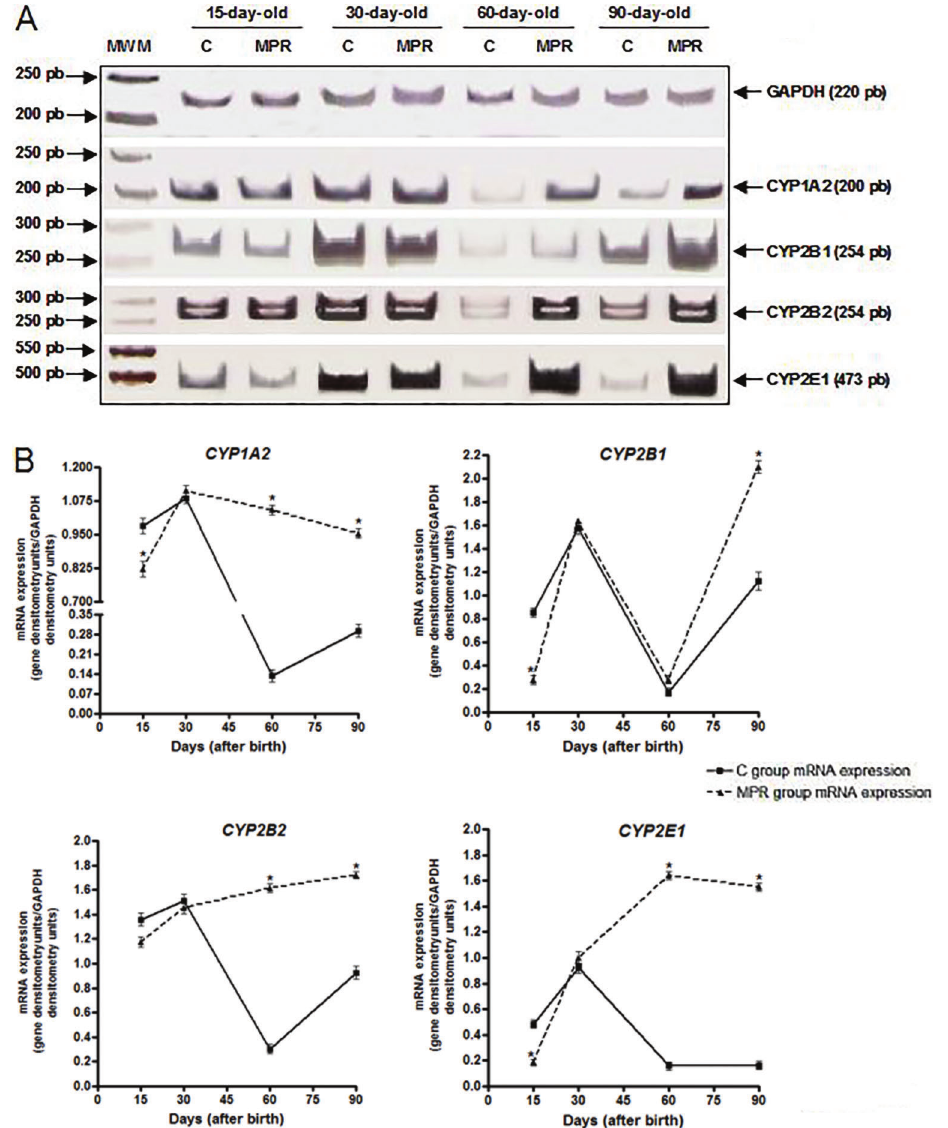
Figure 1. Protein-free diet during lactation modulates the offspring hepatic CYPs mRNA expression at adulthood. A , representative images of hepatic CYP1A2 , CYP2B1 , CYP2B2 and CYP2E1 mRNA expression in 15-, 30-, 60- and 90-day-old offspring from dams fed either a 0% protein (MPR groups) or a standard diet (C groups) during the fi rst ten days of lactation, evaluated by RT-PCR in a 6% polyacrylamide gel; CYP1A1 expression was not detected. B , Densitometric analysis of CYP1A2 , CYP2B1 , CYP2B2 and CYP2E1 mRNA expression. Data are reported as median and standard deviation of three biological replicates and normalized by GAPDH analysis (mRNA expression data derived from three independent pools of 6 males from each group, i.e., N=3). MWM: molecular weight marker (pEJ3 plasmid DNA digested with using Eco147II and PvuI). *P o 0.05 for MPR samples compared to their C counterpart samples (Student ’ s t